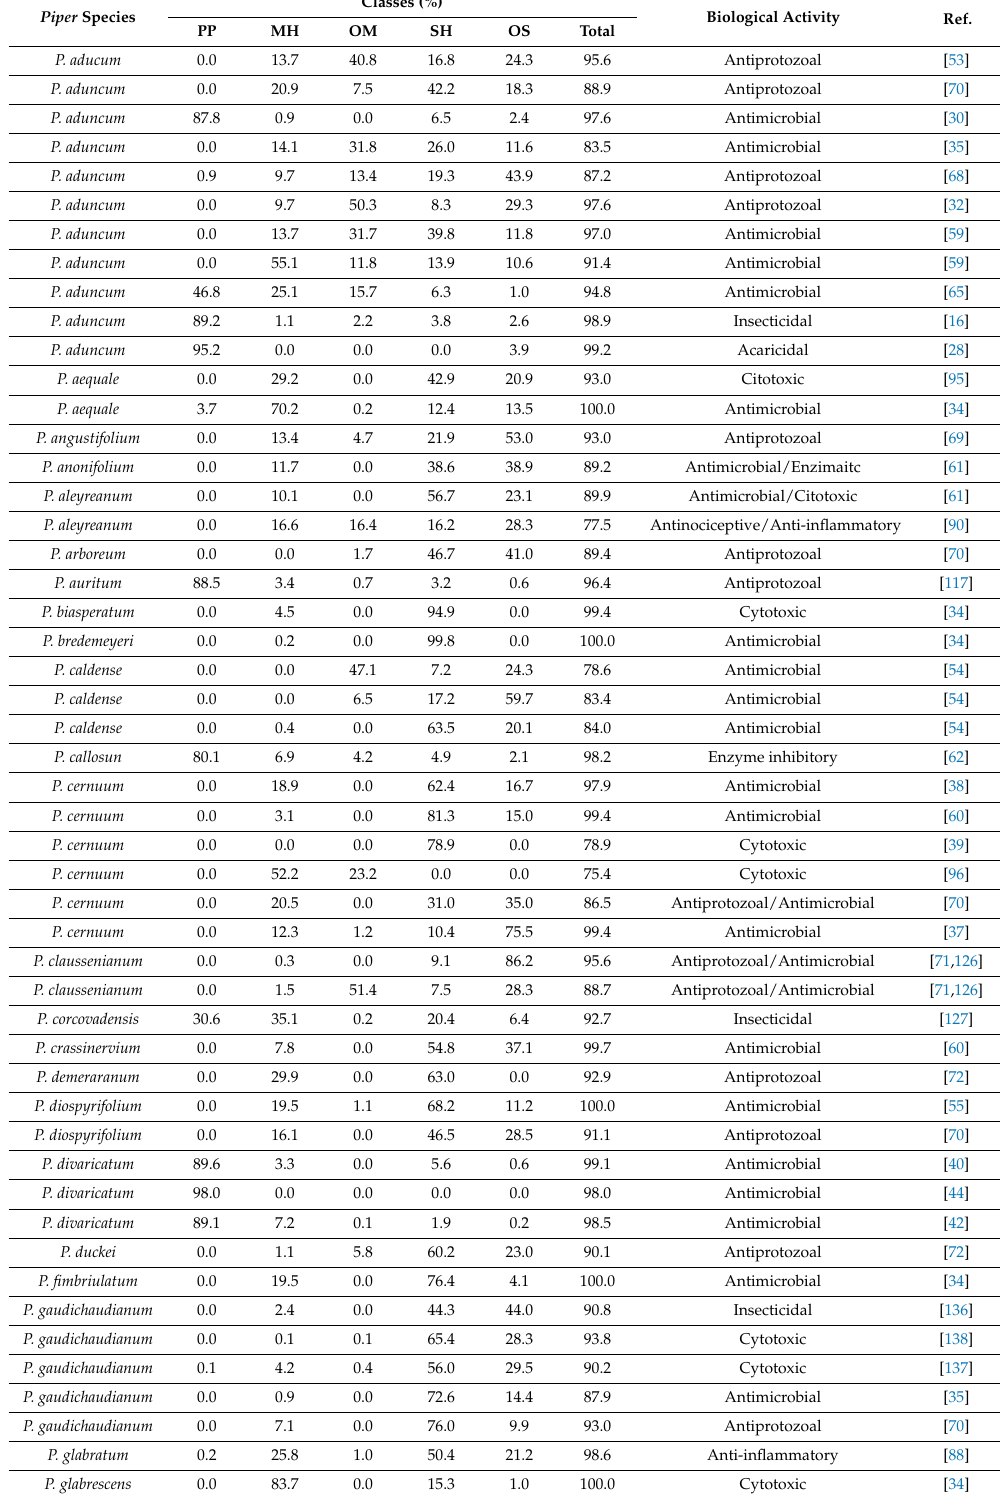
Chemical classes and concentrations of Piper essential oils used for the principal component